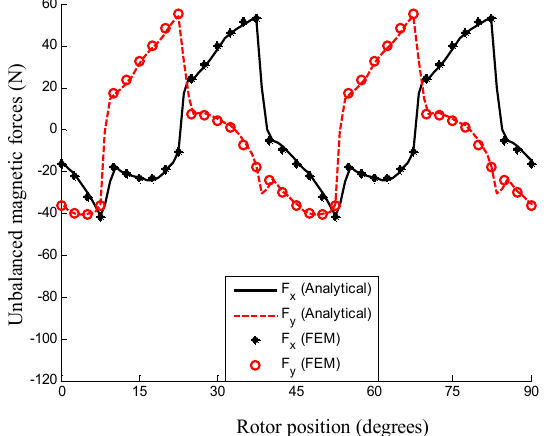
Figure 15. Unbalanced magnetic forces just due to the PMs.